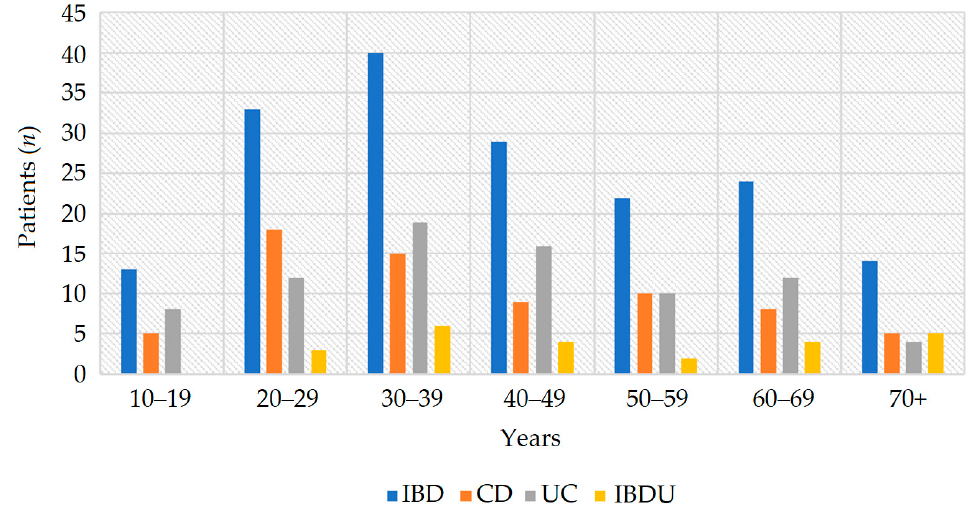
Figure 1. Distribution of IBD diagnosis according to age groups. Abbreviations: CD, Crohn’s disease; IBD, inflammatory bowel disease; IBDU, IBD unclassified; UC, ulcerative colitis.